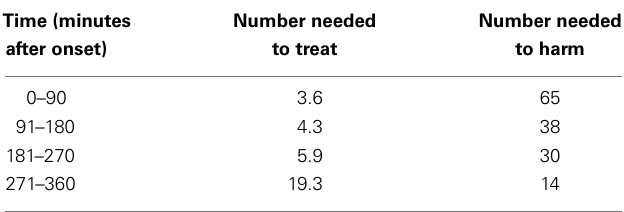
Table based on work by Lansberg et al.